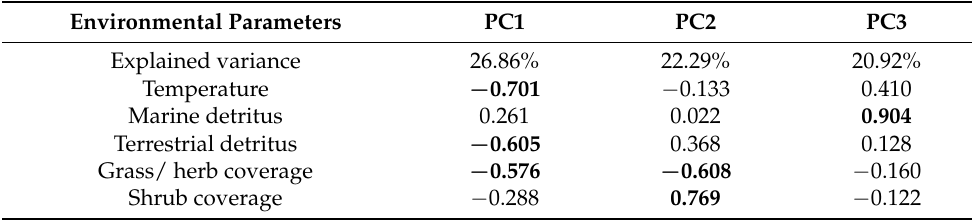
Table 1. Loadings of the PCA analysis for the environmental parameters. Bold values indicate major contributions of an environmental parameter to the principal component. The first three PCs explained in total 70.07% of the total